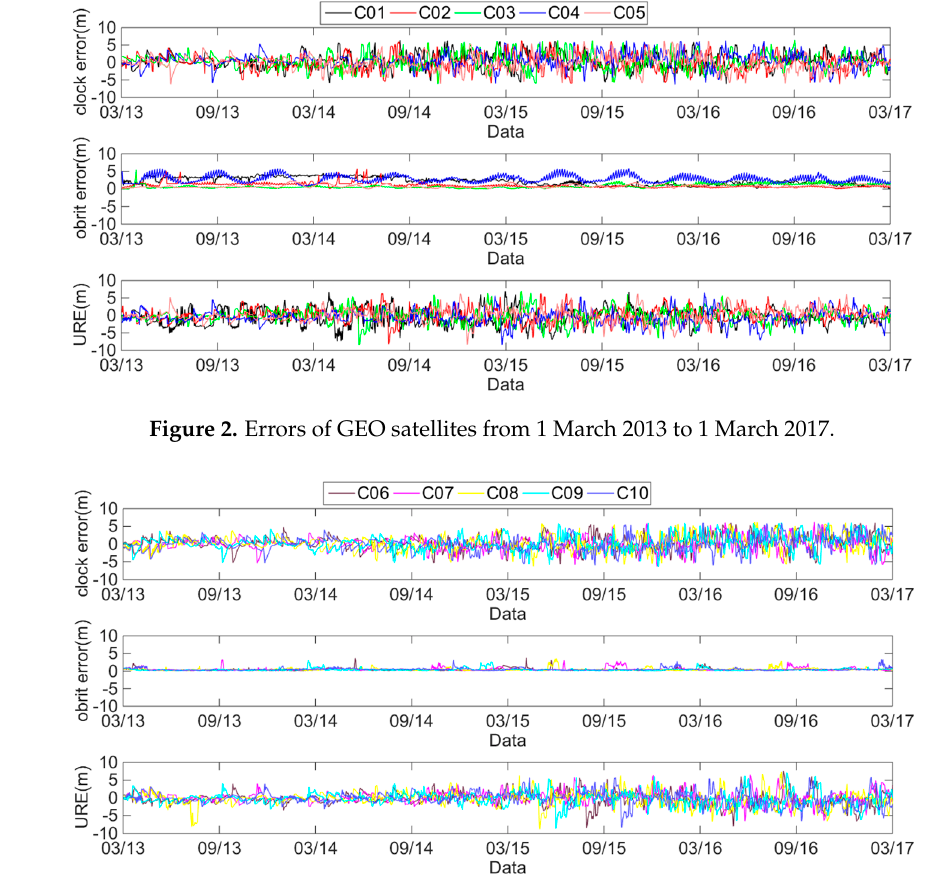
Figure 3. Errors of IGSO satellites from March 1, 2013 to March 1, 2017.